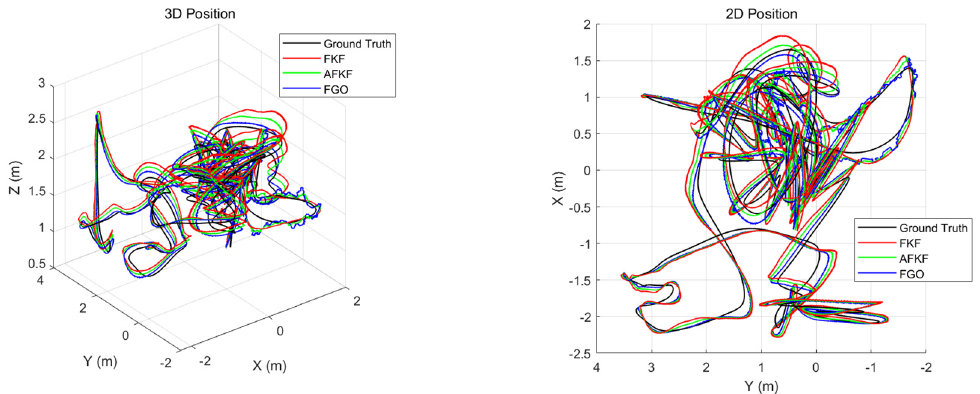
Figure 17. Comparison of 3D position and 2D position of different algorithms in V1_03_difficult scene.